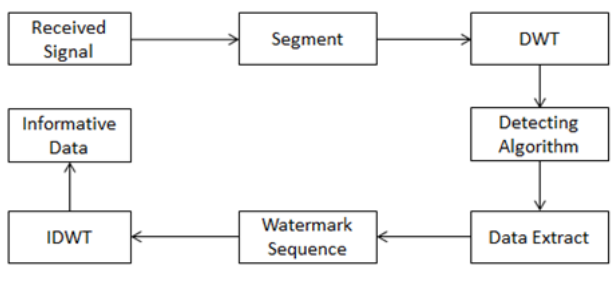
Figure 4. Watermark extraction model.